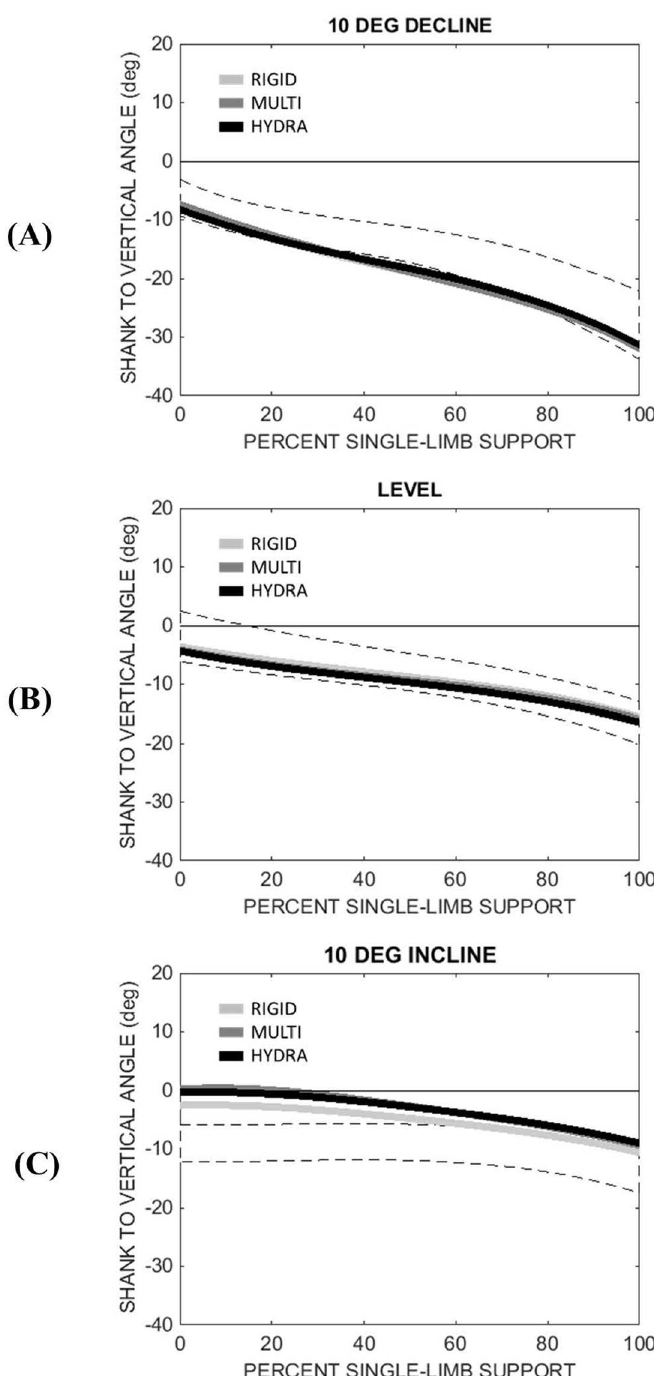
Fig 6. Mean Shank to Vertical Angle (SVA) of subjects with transtibial amputation (n = 7) during single-limb support for the following sloped walking conditions: (A) 10˚ decline, (B) level, and (C) 10˚ incline. Dashedbandcorrespondsto the mean SVA ( ± 1 standard deviation) of an able-bodied control group (n = 7). Positive anglescorrespondto a reclinedshank posture (i.e., the posture that wouldbe expectedat initial